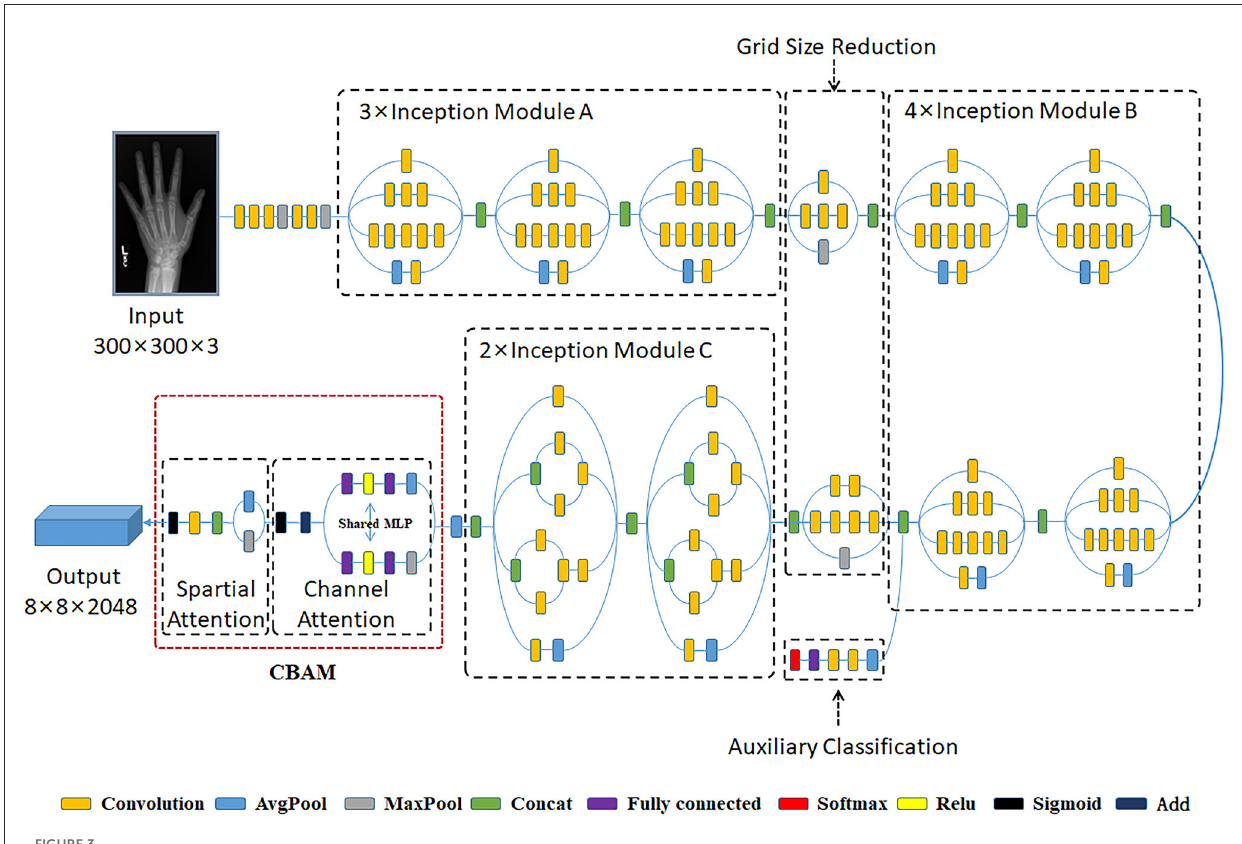
FIGURE3 The architecture of Inception V3 with Convolutional Block Attention Module.